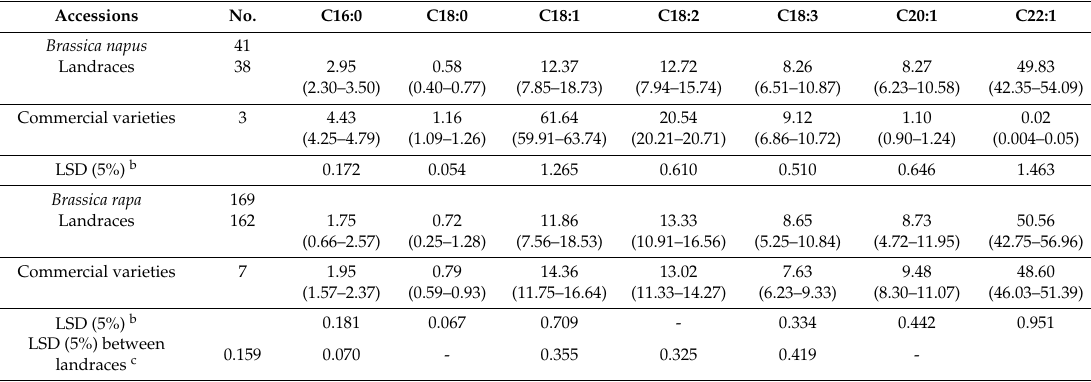
Table 3. Fatty acid composition a of the seed oil (mean, minimum and maximum values) of B. napus and B. rapa varieties from northwestern